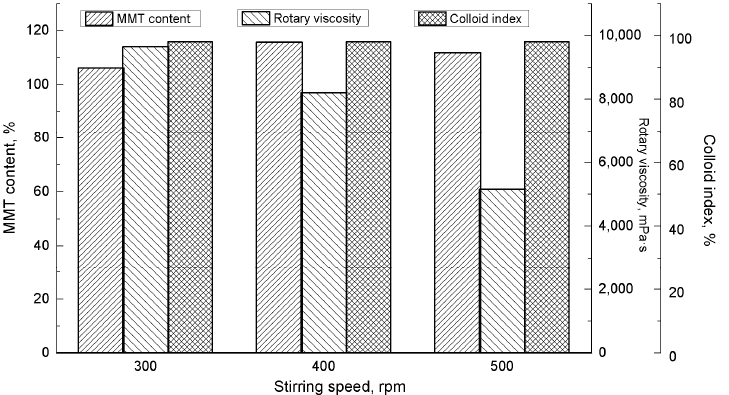
Figure 4. Properties of the montmorillonite (MMT) as a function of the stirring speed (reaction conditions: sodium carbonate mass = 2.8%, 2 h, and 25 °C).